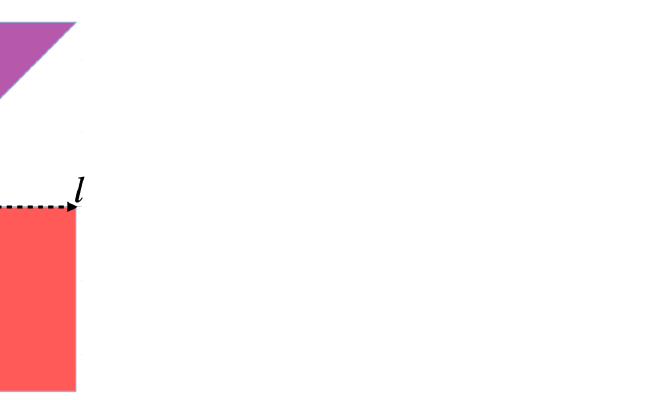
Figure A2. The numbered regions are derived from the corresponding conditions of Theorem 2. The regions specify all l and g such that there exists an NE profile in SRSs for the repeated modification of G 00 .